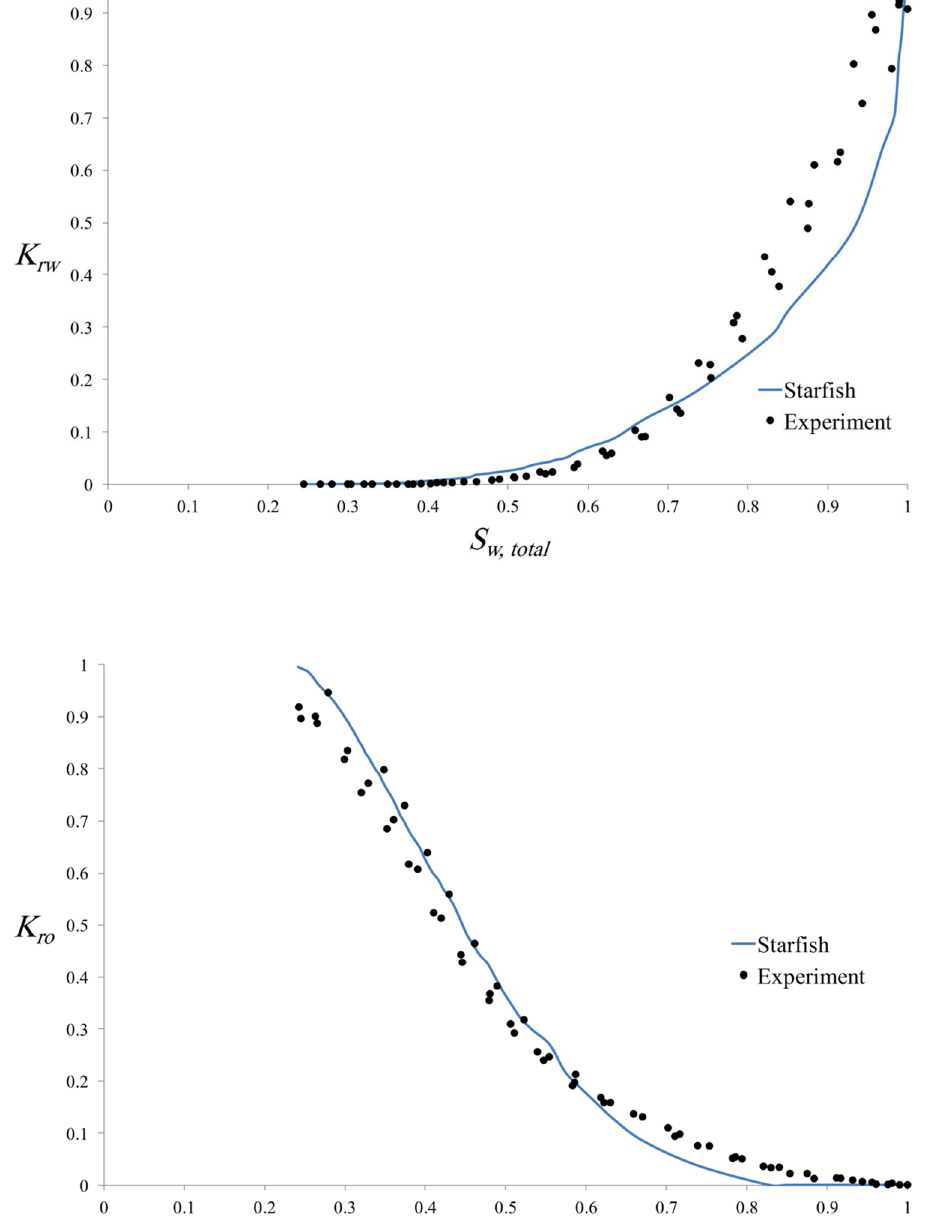
Fig. 2 Simulated and experi- mental water relative permeabil- ity in drainage process